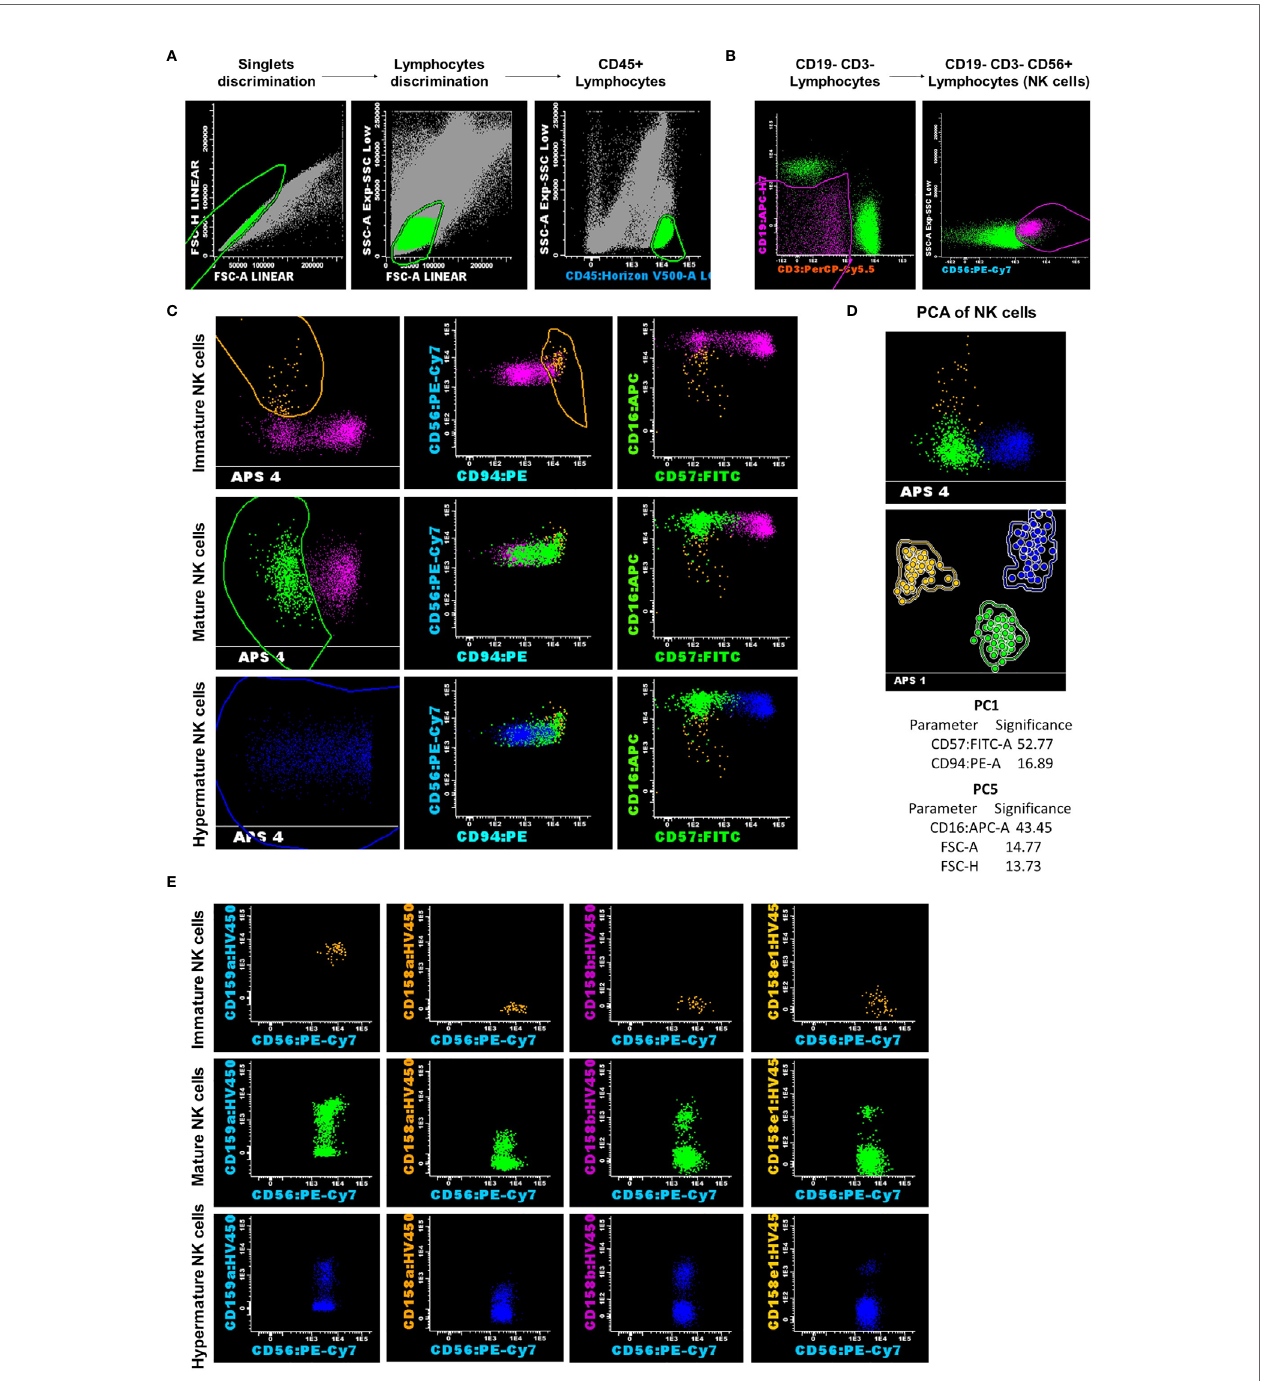
FIGURE 1 | Representative example for NK analysis strategy and classi fi cation into three subsets: CD56 bright CD94 hi CD16 − CD57 − as the immature subset (yellow dots); CD56 dim CD94 med CD16 + CD57 − as the mature subset (green dots); andCD56 dim CD94 low CD16 + CD57 + asthehypermaturesubset(bluedots). (A) Lymphocytes gatingonthesidescatter (SSC)vsCD45 dot-plots. (B) NKcellsweregatedaccordingtoCD56 expressionandtheabsenceofCD3 andCD19. (C,D) ReliableseparationofNK cells into subsetswasobtainedusingthe PrincipalComponentAnalysis(PCA) forallanalyzedcases,regardless ofthegroup.Dots andcirclesrepresentthemedianvalues of individualcases, andthesolidlinerepresentsthe 2SDcurvefor anNKsubset(yellow, CD56 bright CD94 hi CD16 − CD57 − representstheimmaturesubset; green, CD56 dim CD94 med CD16 + CD57 − representsthematuresubset;andblue, CD56 dim CD94 low CD16 + CD57 + represents thehypermaturesubset). Thetableshowsthecontributionofthe mostrelevantparameters(thosemarkersthatreceivedaweightover 10) tothe fi rst(PC1, x-axis) or second(PC5, y-axis) principalcomponentre fl ectedas percentvalues. (E) DistributionofCD159aandKIR receptors